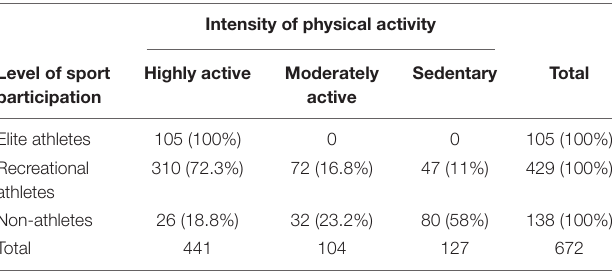
TABLE 1 | Cross-tabulation of the level of sport participation and the intensity of physical